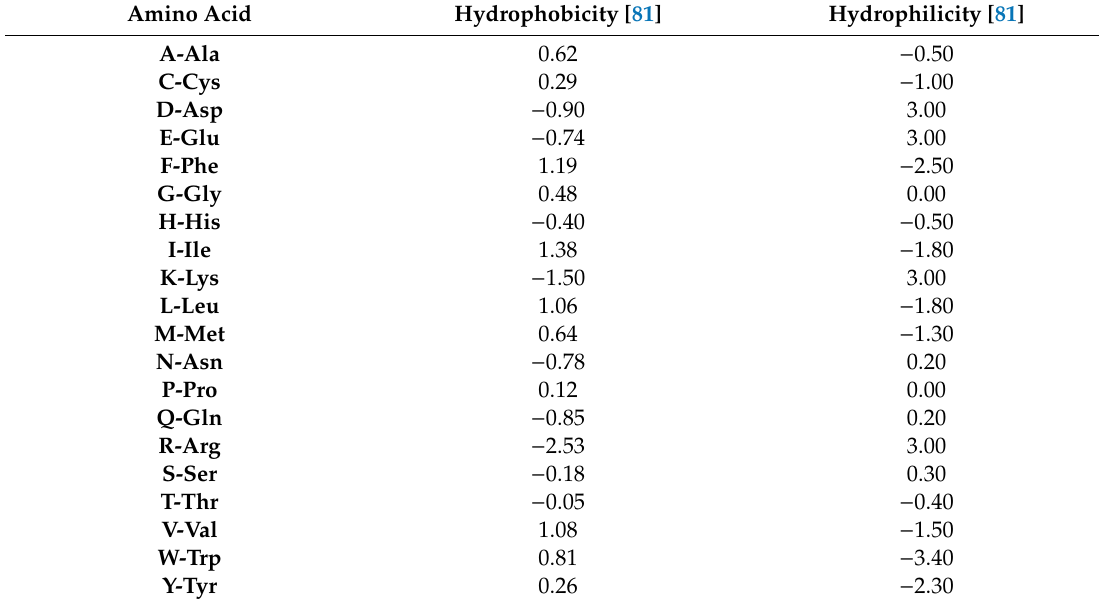
Table A1. Original values of hydrophobicity and hydrophilicity for 20 amino